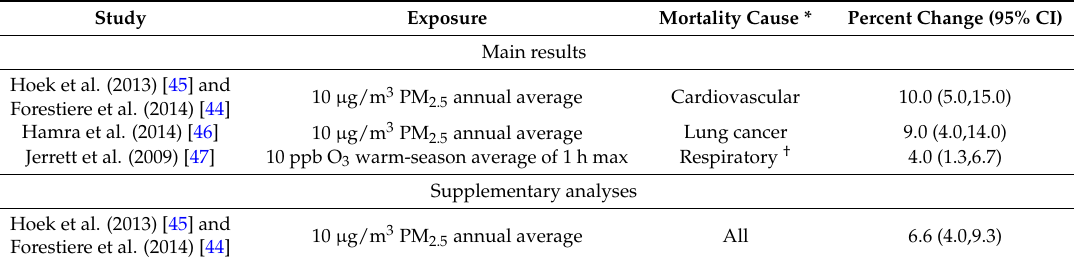
Table 1. Concentration-response functions used in estimating health